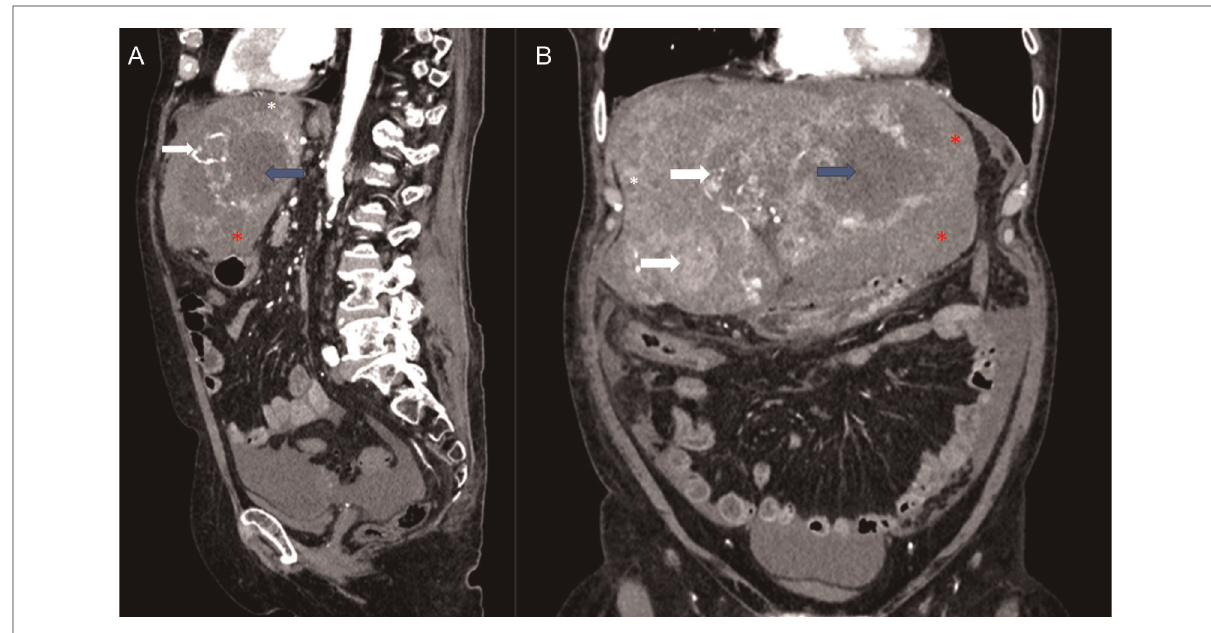
FIGURE 2 Abdominal frontal ( A ) and sagittal ( B ) CT images showing recurrent HCC (white arrow), liver hematoma (red arrow) and multiple liver abscesses (blue arrow).